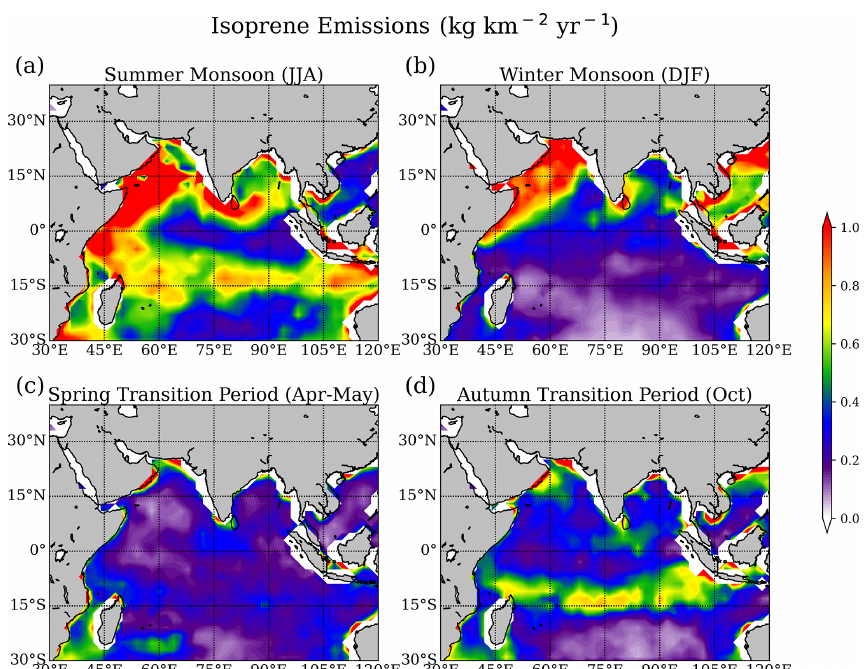
Figure 9. Isoprene emissions for (a) summer monsoon (June–August), (b) winter monsoon (December–February), (c) spring transition (April–May), and (d) autumn transition (October) from Booge et al. (2016).